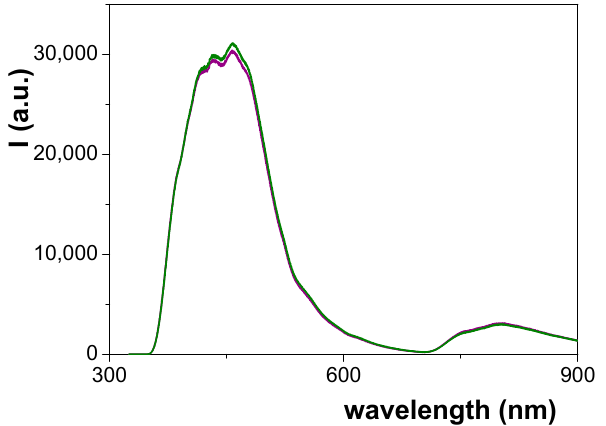
Figure 9. Photoluminescence spectra for Ox–SiO 2 /APTES sample (green line) and Ox- SiO 2 /APTES/O 3 sample (purple line).